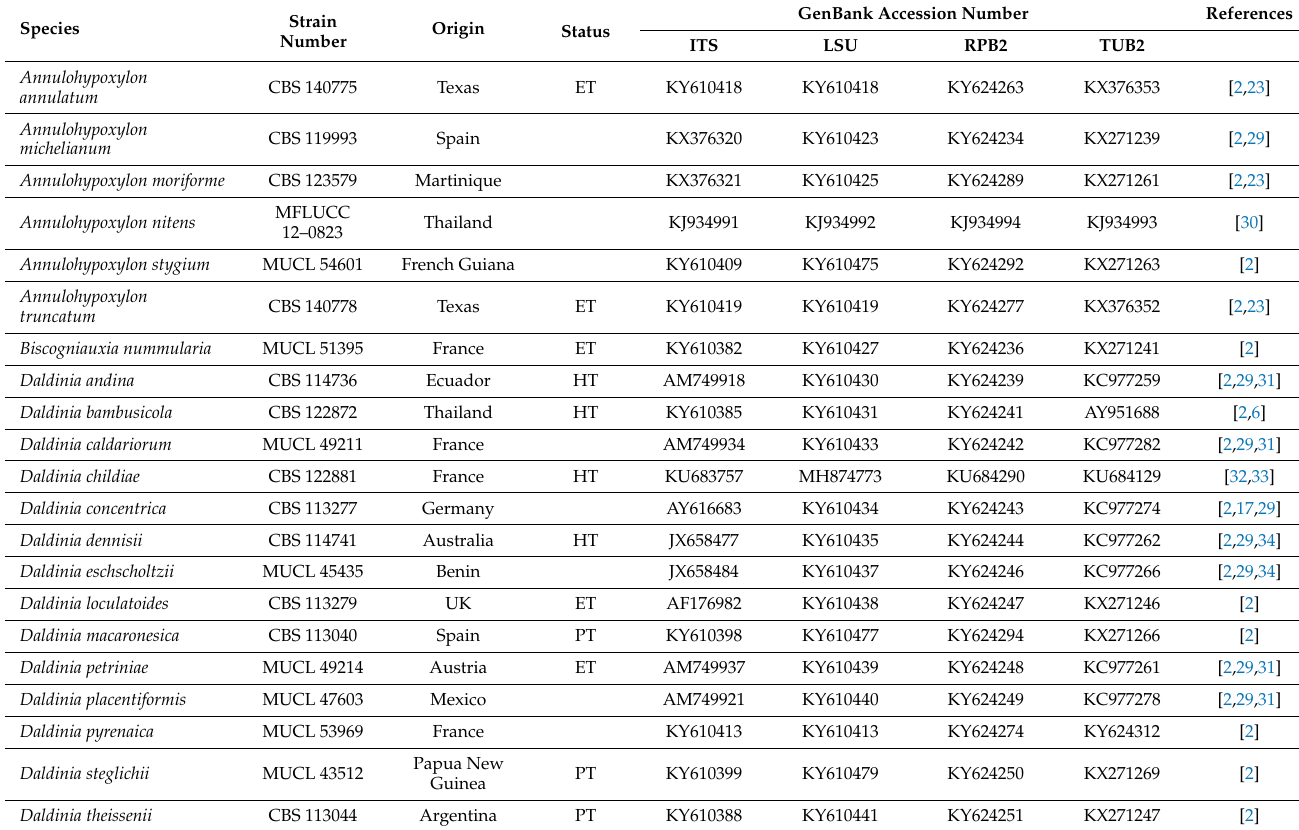
Table 1. Isolation and accession numbers of sequences used in the phylogenetic analyses. Type specimens are labeled with HT (holotype) ET (epitype) and PT (paratype). Isolates/sequences in bold were isolated/sequenced in present study. N/A: not